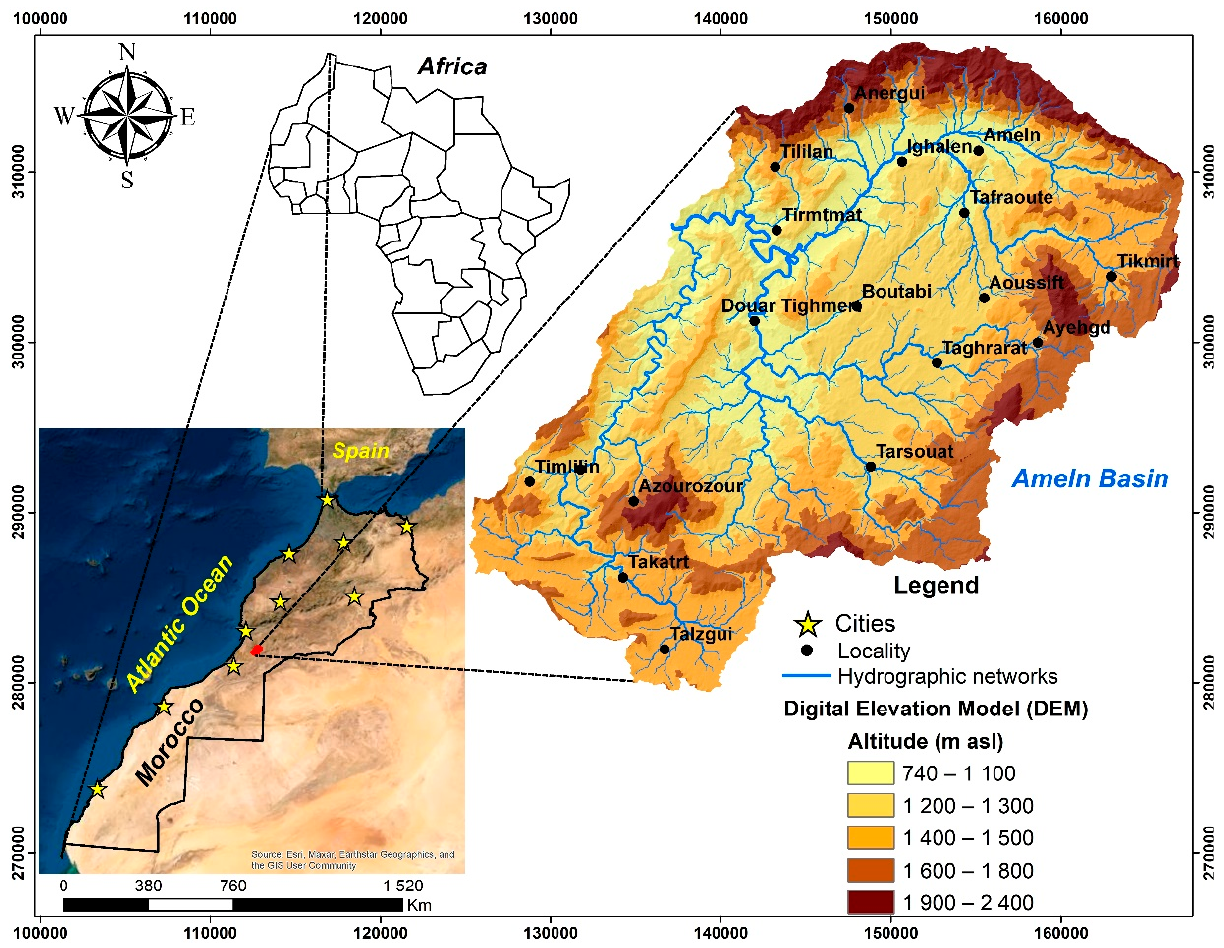
Figure 1. Geographic location of the Ameln Basin.